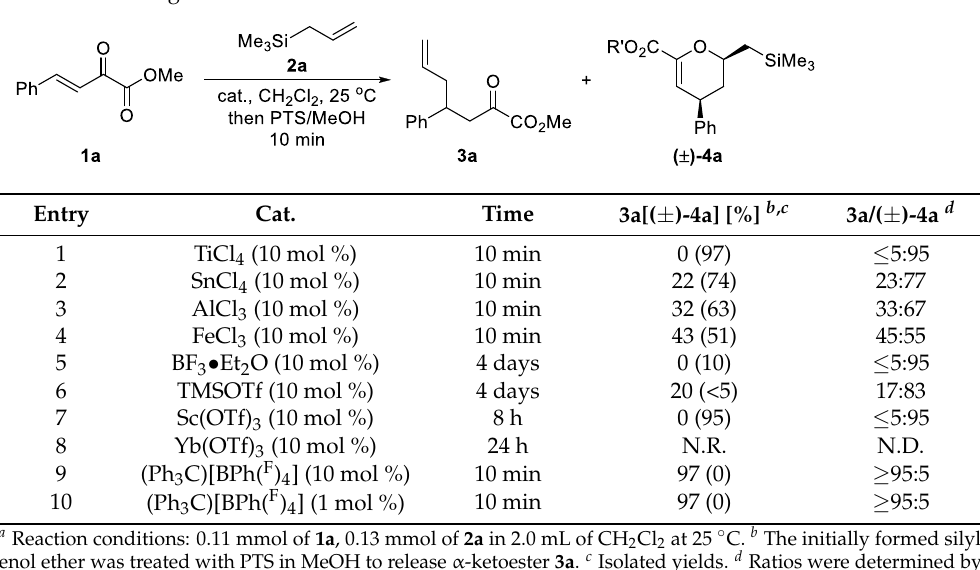
Table 1. Screening of Reaction Conditions a .